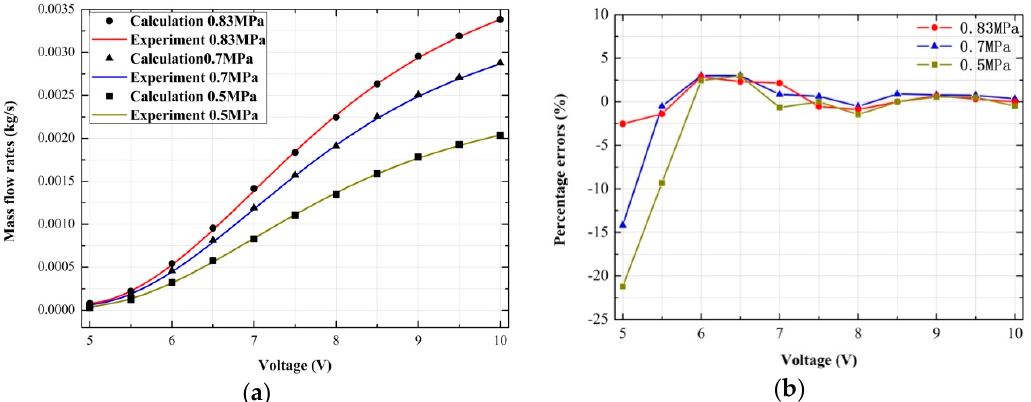
.  M 4 with different driving voltages and their errors: ( a ) Mass flow M with different driving voltages and their errors: ( a ) Mass 4